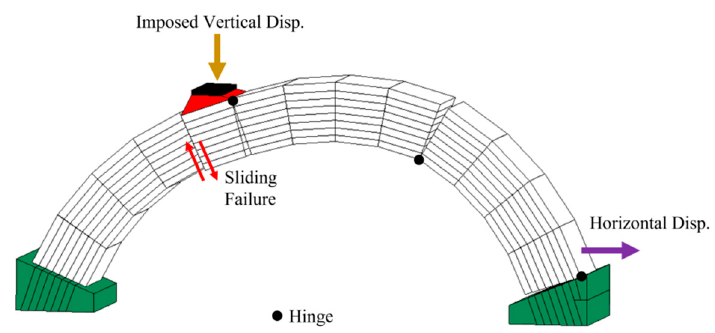
Figure 3. Discrete elements and the failure mode (plastic hinges and sliding failure) from DEM, reproduced from [32].